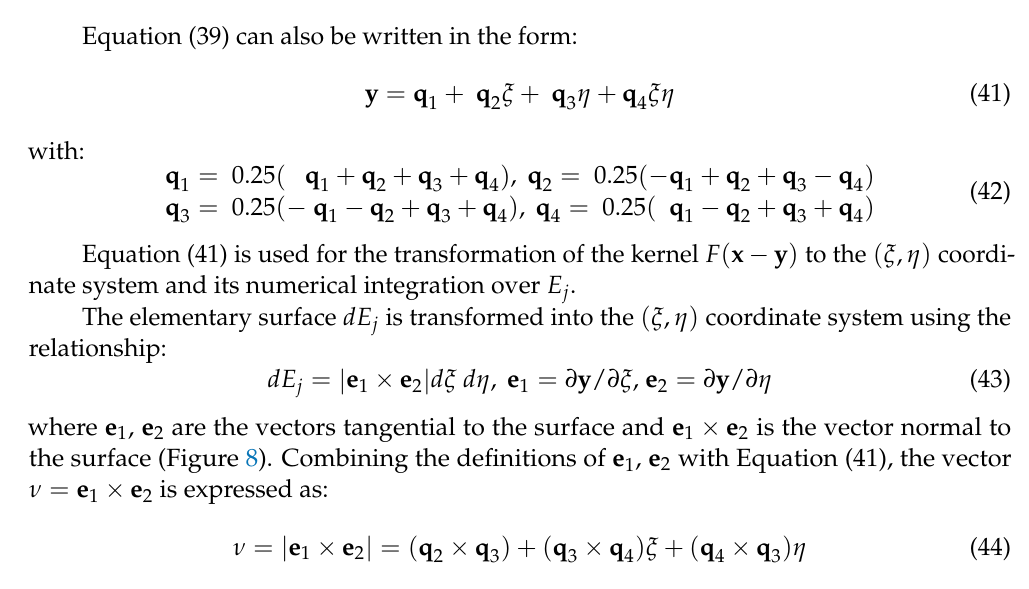
e , e tangential to the elementary surface dE 1 2